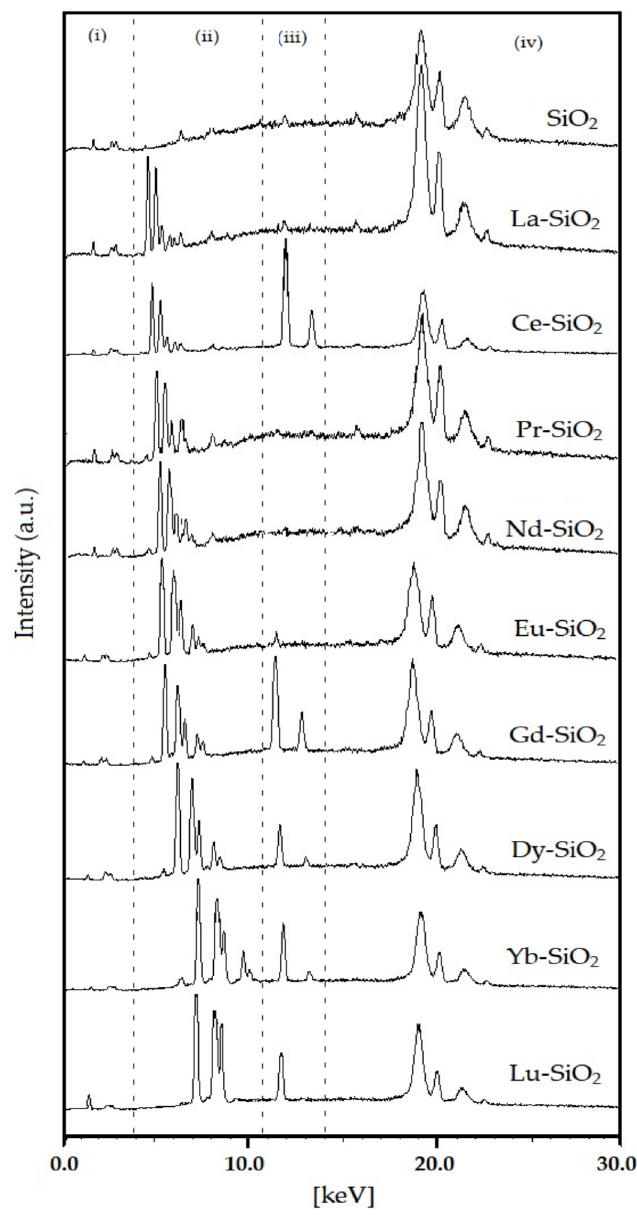
Figure 3. Energy dispersive XRF spectra of calcined samples Ln-SiO 2 (Ln = La, Ce, Pr, Eu, Nd, Gd, Dy, Yb, Lu).